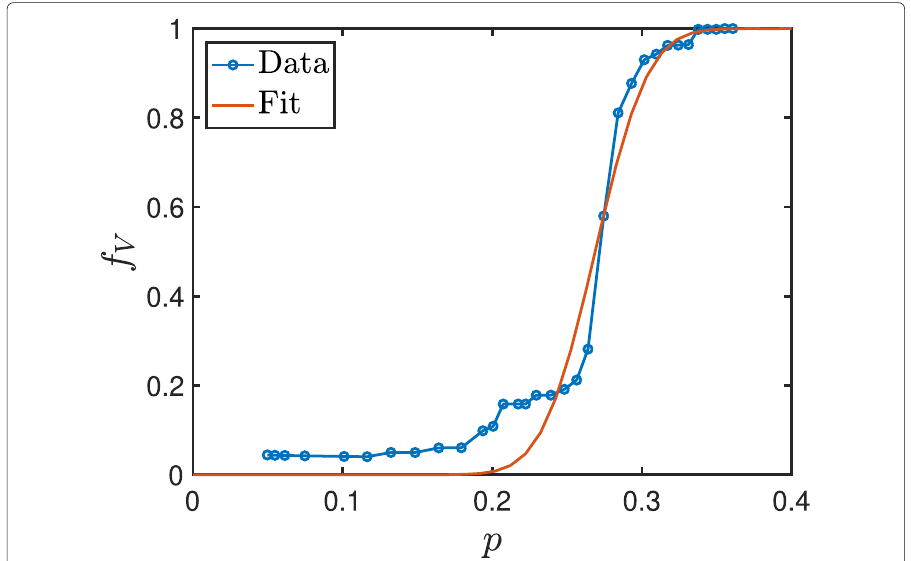
Fig. 8 Fraction of total bubble volume that is connected to a free surface, f V , as a function of porosity p for M = 1, Configuration 1, and function fit to the data using Eq.